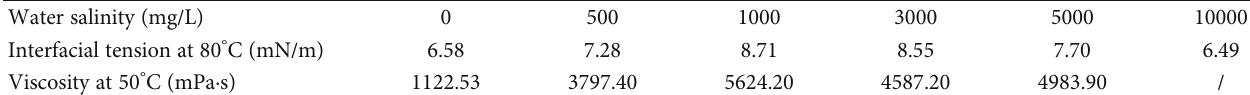
Table 7: The IFT and viscosity of emulsion obtained with di ff erent salinities. Water salinity (mg/L)